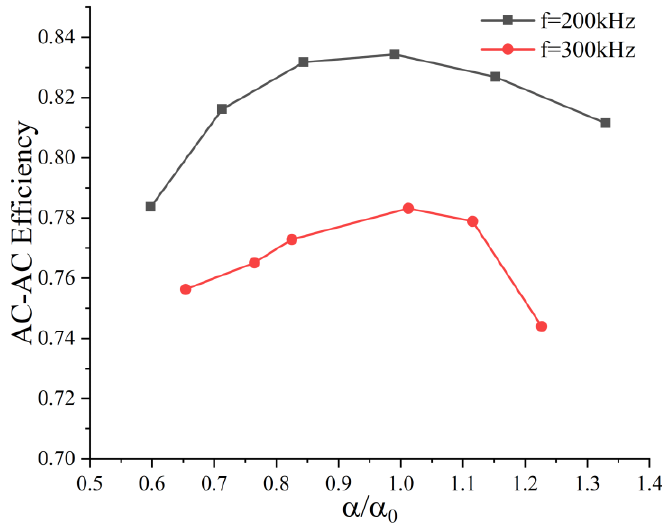
Figure 14. AC-AC efficiency varies with α/α 0.